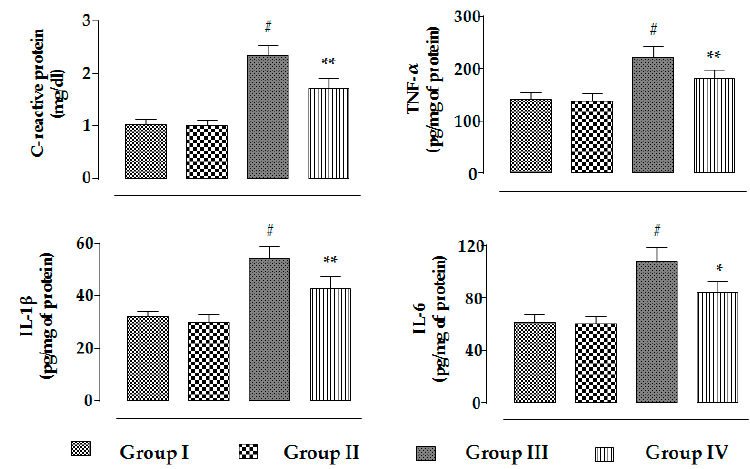
Figure 7. The effects on serum inflammatory markers, i.e., C-reactive proteins, THF- α , IL-1 β , and IL-6, in the absence (CdCl 2 ) and presence of RA (CdCl 2 + RA) in vivo on mouse kidneys. Data are represented as means ± SD, n = 6 (number of plates). # Values significantly ( p < 0.01) differ from normal control. * Values significantly ( p < 0.05) differ from CdCl 2 control. ** Values significantly ( p < 0.01) differ from CdCl 2 control.